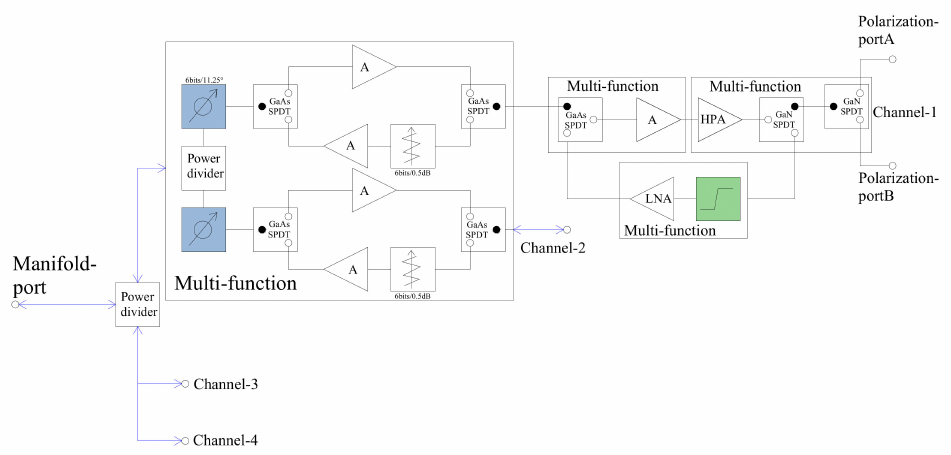
Figure 1. Tile-type functional block